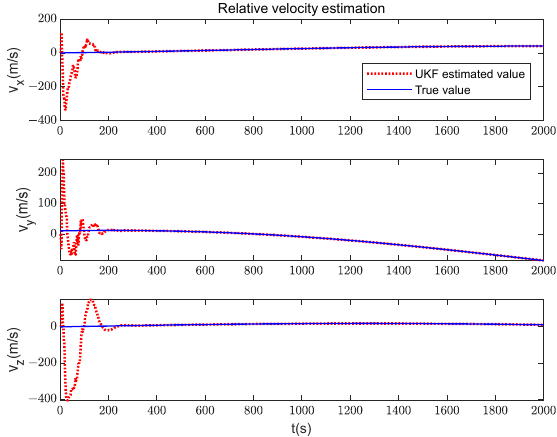
Figure 10. Comparison of relative position parameters.